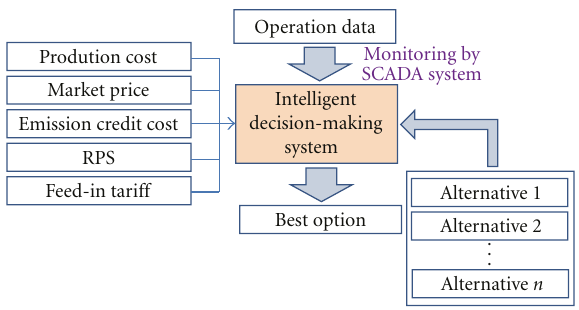
Figure 7: Feed-in tari ff application.